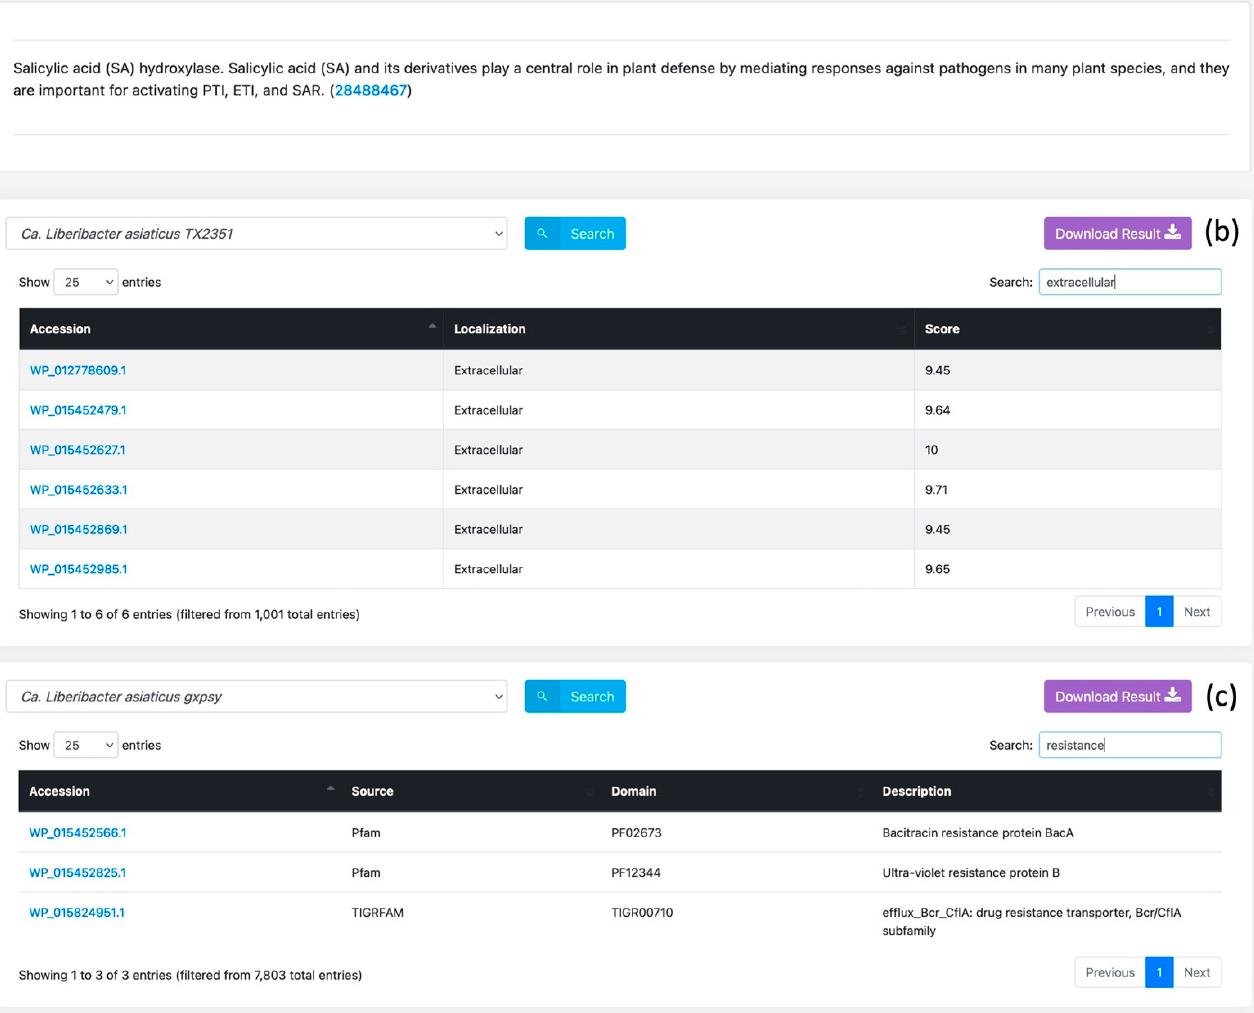
Figure 1. Examples of the annotation features of the GreeningDB search modules. ( a ) Description of WP_012778388.1, a ‘ Ca . Liberibacter asiaticus’ str. psy62 protein; ( b ) Proteins that are located extracellularly in ‘ Ca . Liberibacter asiaticus’ str. TX2351; ( c ) Proteins found with a “resistance” functional domain in ‘ Ca . Liberibacter asiaticus’ str. gxpsy.